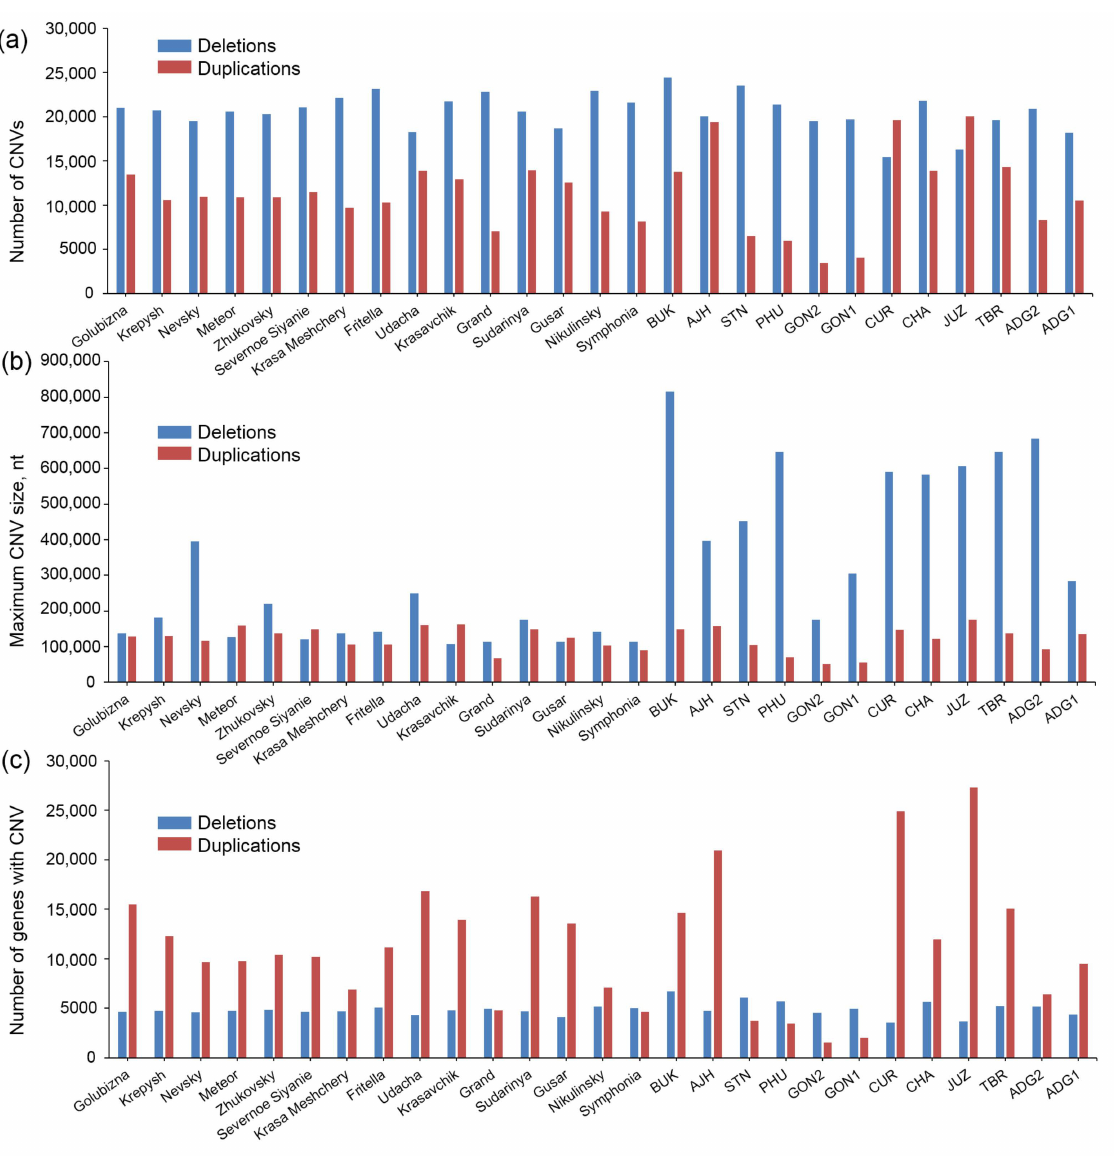
Figure 4. Distribution of CNV quantitative characteristics in the genomes of Russian cultivars and South American potato species accessions. ( a ) Distribution of the number of duplications and deletions; ( b ) distribution of maximum lengths of deletions and duplications; ( c ) distribution of the number of genes with deletions and duplications. See Table 2 for abbreviation of the names of South American